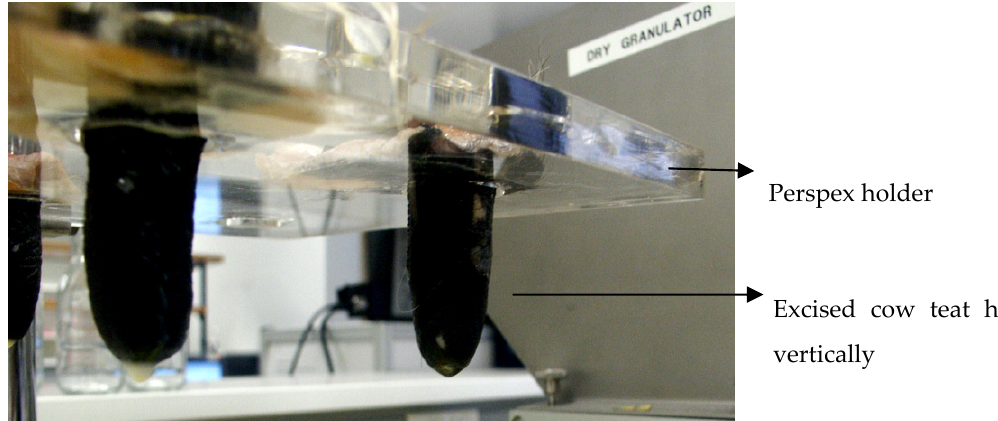
Figure 1. New ex vivo setup to study in situ gelling, retention and biocompatibility of formulations in excised bovine teats.